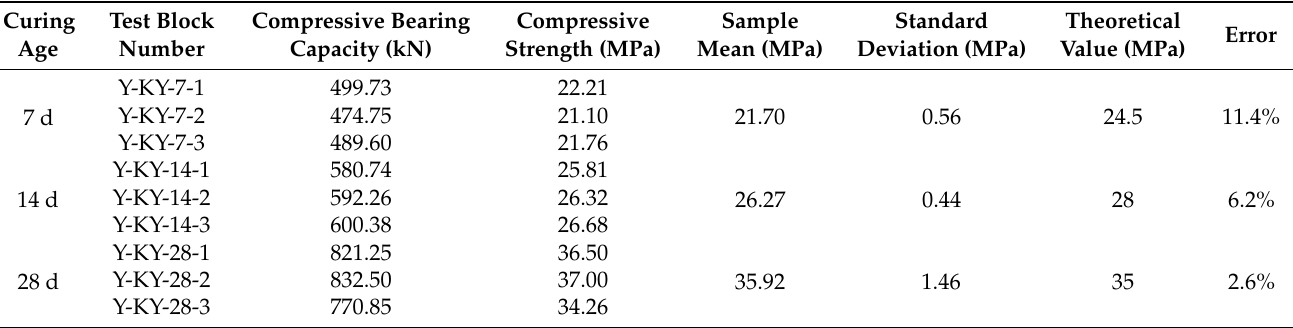
Figure 2. Compressive strength tests. ( a ) Compressed test block; ( b ) damaged test block. Table 1. Compressive strength of C35 concrete at different ages.